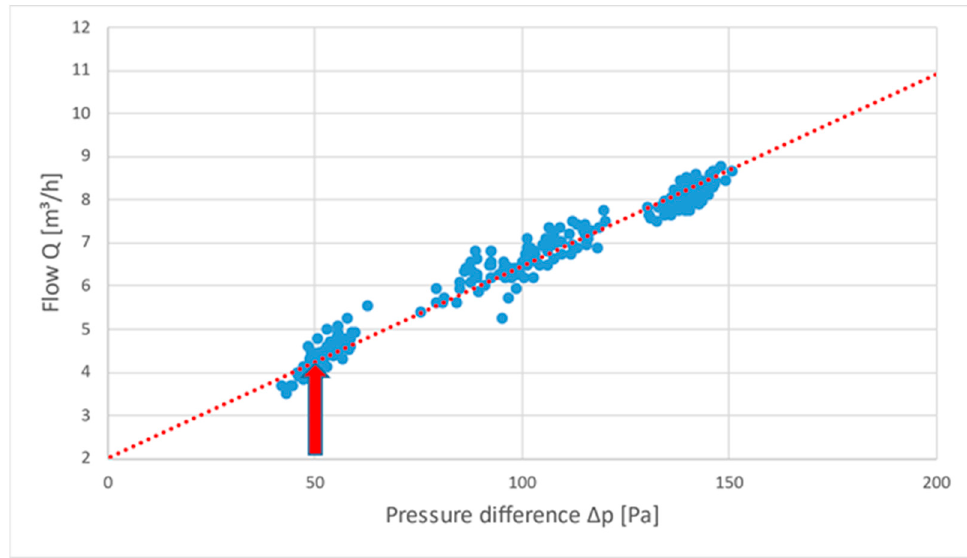
Figure 12. The air permeability after drying (dry state), 21 February 2022 (probe V2 17.3%) Q 50 = 4.39 m 3 /h, q 50 = 1.79 m 3 /(m 2 .h).